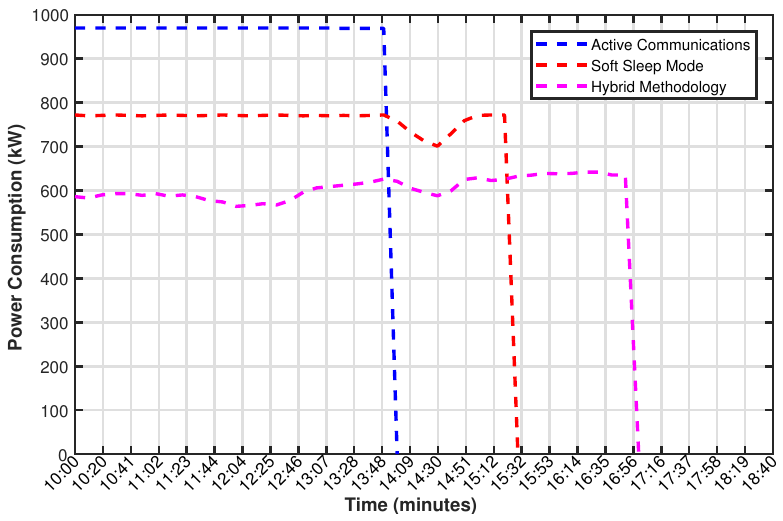
Figure 3. Comparison of power consumption from the highest priority